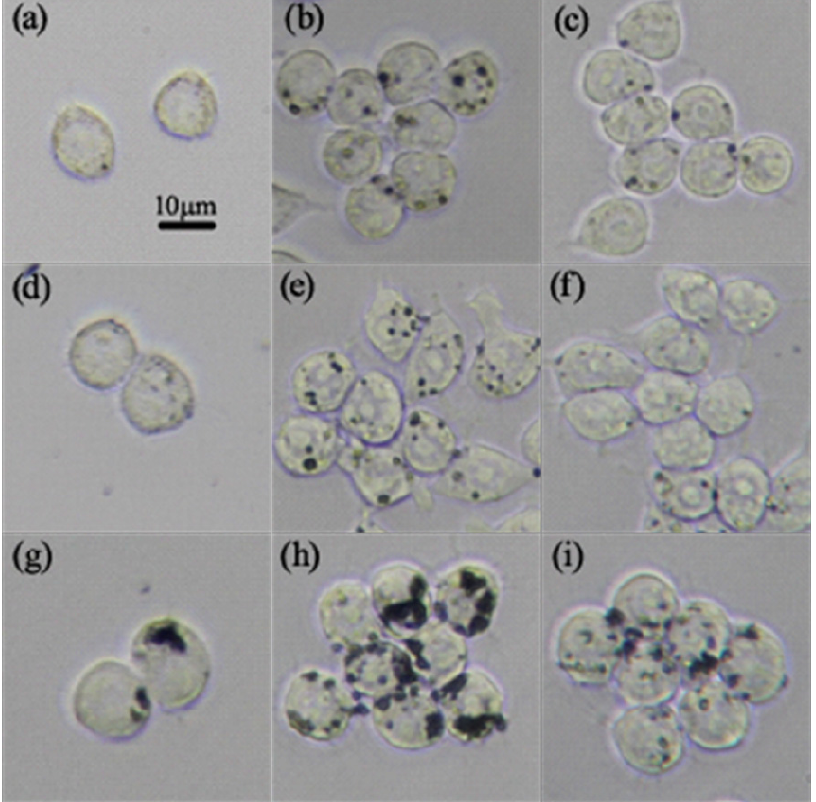
Figure 4. Optical microscope images of RAW264.7 cells after incubation with 50 μ g·mL − 1 different sized NCBs. ( a , d , g ) Cells after 2 h incubation with NCBs; ( b , e , h ) Cells after 24 h incubation with NCBs; ( c , f , i ) Cells after 48 h incubation with NCBs; ( a – c ) Printex 90; ( d – f ) Printex G; ( g – i ) Flammruss 101. The scale bar corresponds to 10 μ m.